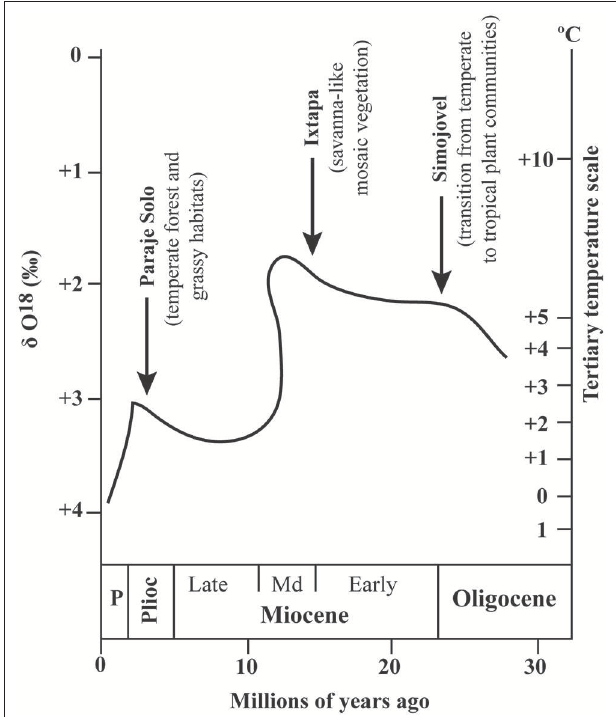
FIGURE 4 | Neogene temperature change based on marine benthic δ O 18 record. The arrows indicate representative palynofloras and related plant communities from the Mexican Neogene (modified from Graham, 1994; Figure 3 ).